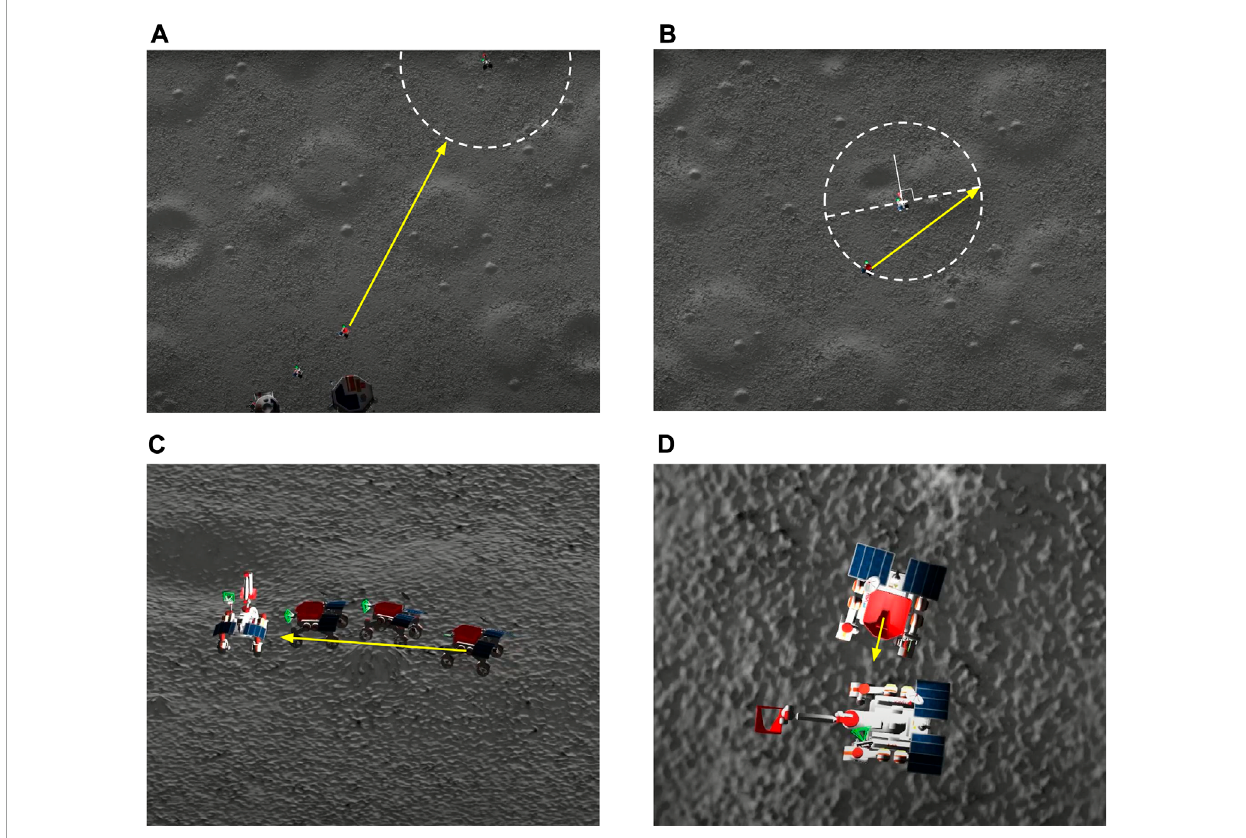
FIGURE 9 Parking Procedure. (A) Once the Excavator arrives at the excavation site, the Hauler drives using its navigation stack and stops at a radius (white dashed circle) from the volatile position in a staging waypoint. Then it waits for new instructions from the Excavator about the best side to park. (B) The Excavator chooses which side it wants the Hauler to park and the Hauler goes to this waypoint, again using its navigation stack. It stops at a 10 m range and perpendicularly to the Excavator’s orientation. Again it waits for the Excavator to instruct it to start approaching. (C) After finding volatile the Excavator requests the Hauler to approach. The Hauler approaches using visual servoing until it gets to a 3 m range. (D) Then it tries several methods to determine a precise position to park. After deciding the best position to park, the Hauler goes to that position using a position-feedback velocity controller and it waits until the load is fully deposited in its bin by the